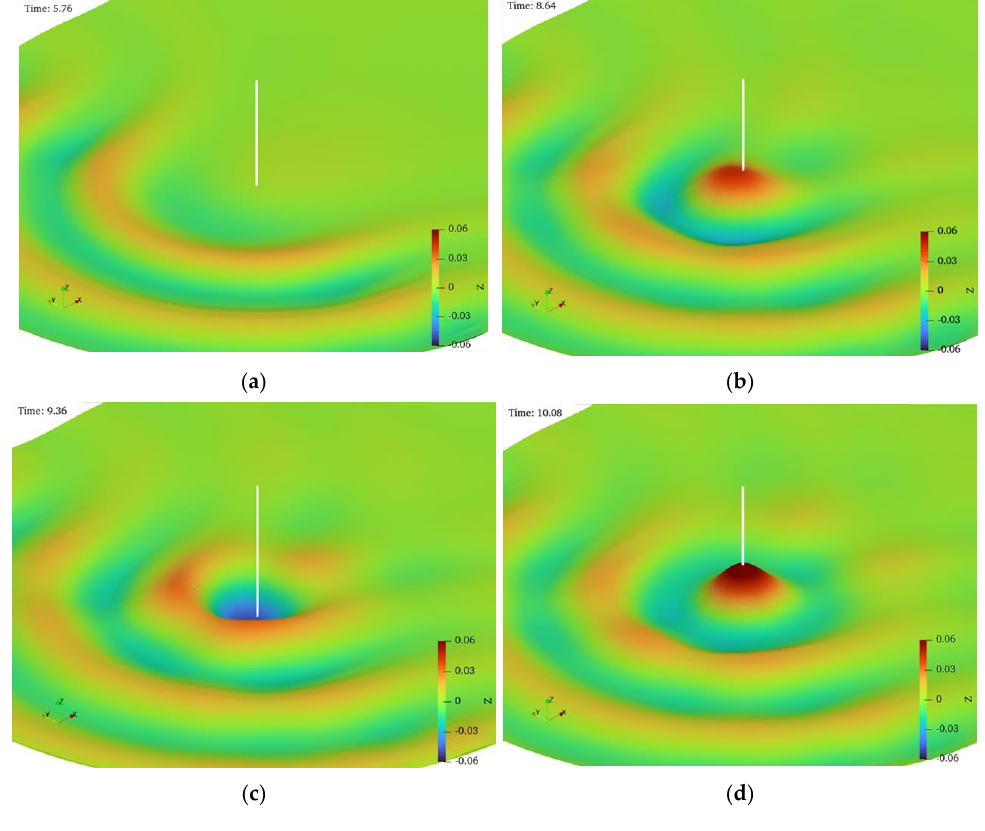
( a ) t/T = 4; ( b ) t/T = 6; ( c ) t/T = 6.5; ( d ) t/T = 7.